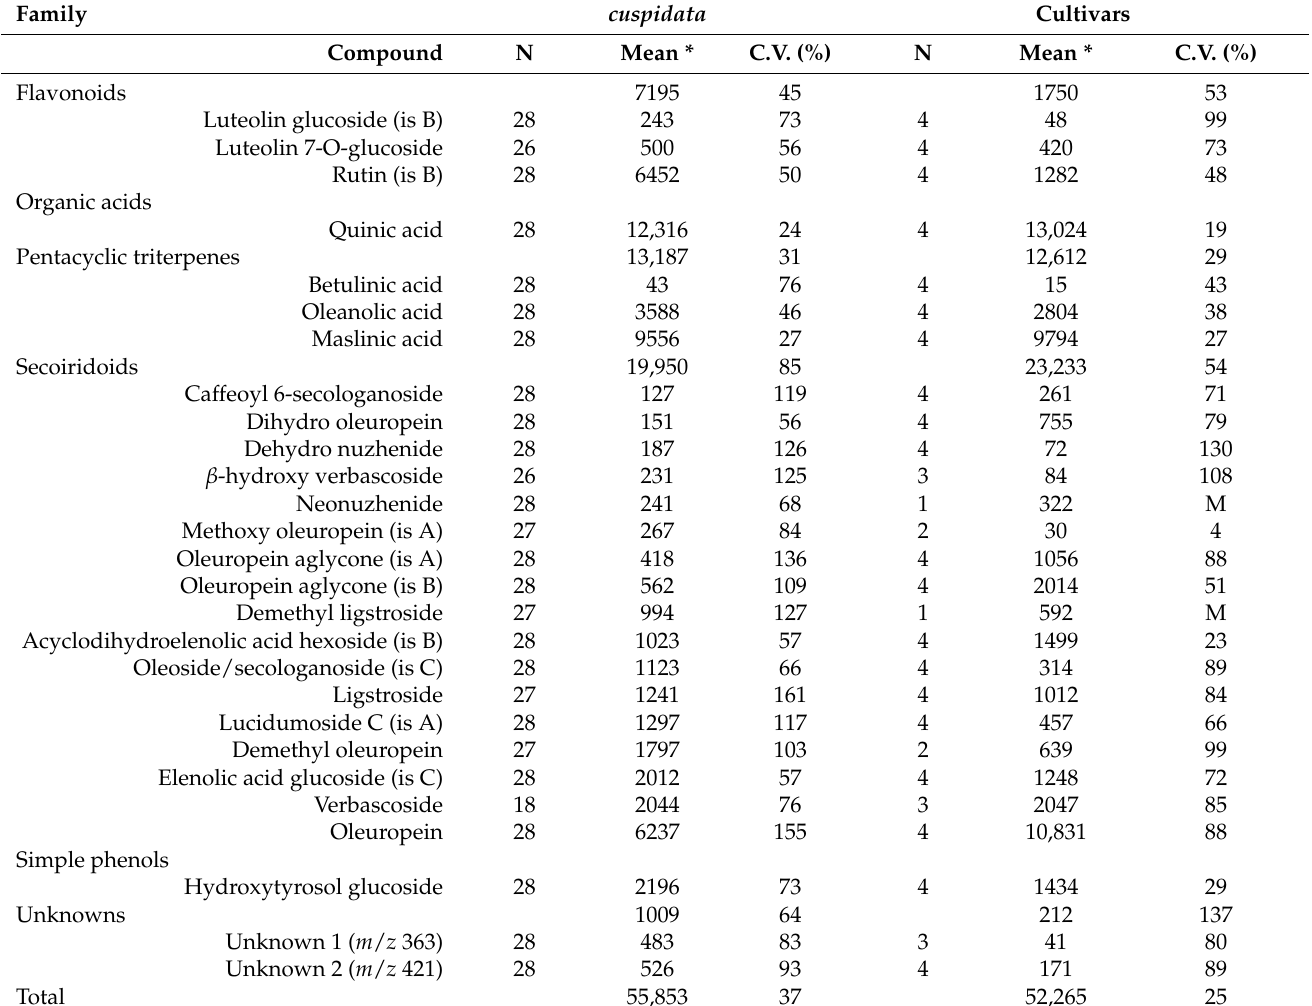
Table 3. Summary of the quantitative data obtained for the metabolites quantified in the cuspidata progeny and female parent, and the cultivars (“Arbequina”, “Frantoio”, “Koroneiki” and “Picual”). The compounds are ordered in the table by chemical classes and increasing concentrations in the progeny. The N column indicates the number of times each compound was quantified in each